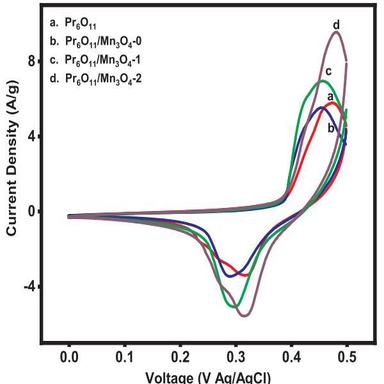
CV curves of Pr6O11 (a), Pr6O11/Mn3O4-0 (b), Pr6O11/Mn3O4-1 (c) and Pr6O11/Mn3O4-2 (d) at a scan rate of 5 mV/s.